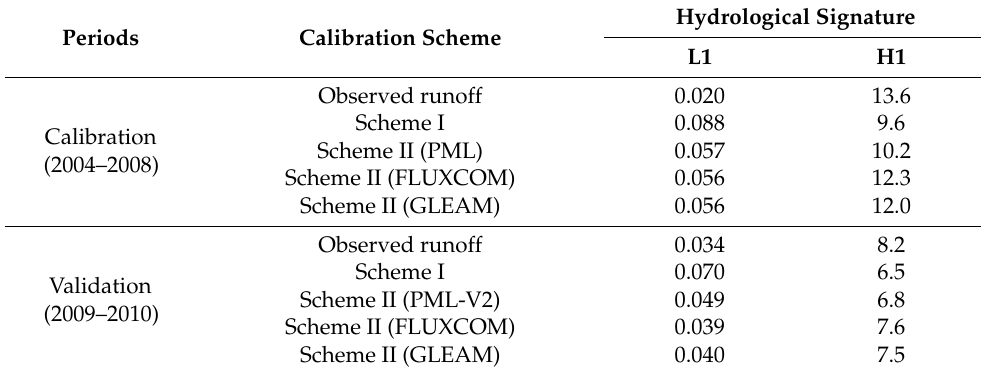
Table 5. The other two hydrological signatures (L1 and H1) in the calibration and validation periods based on Scheme I and Scheme